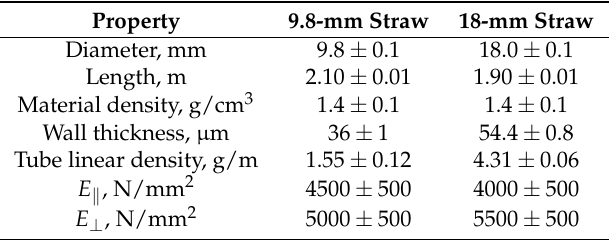
Table 1. Properties of the tested